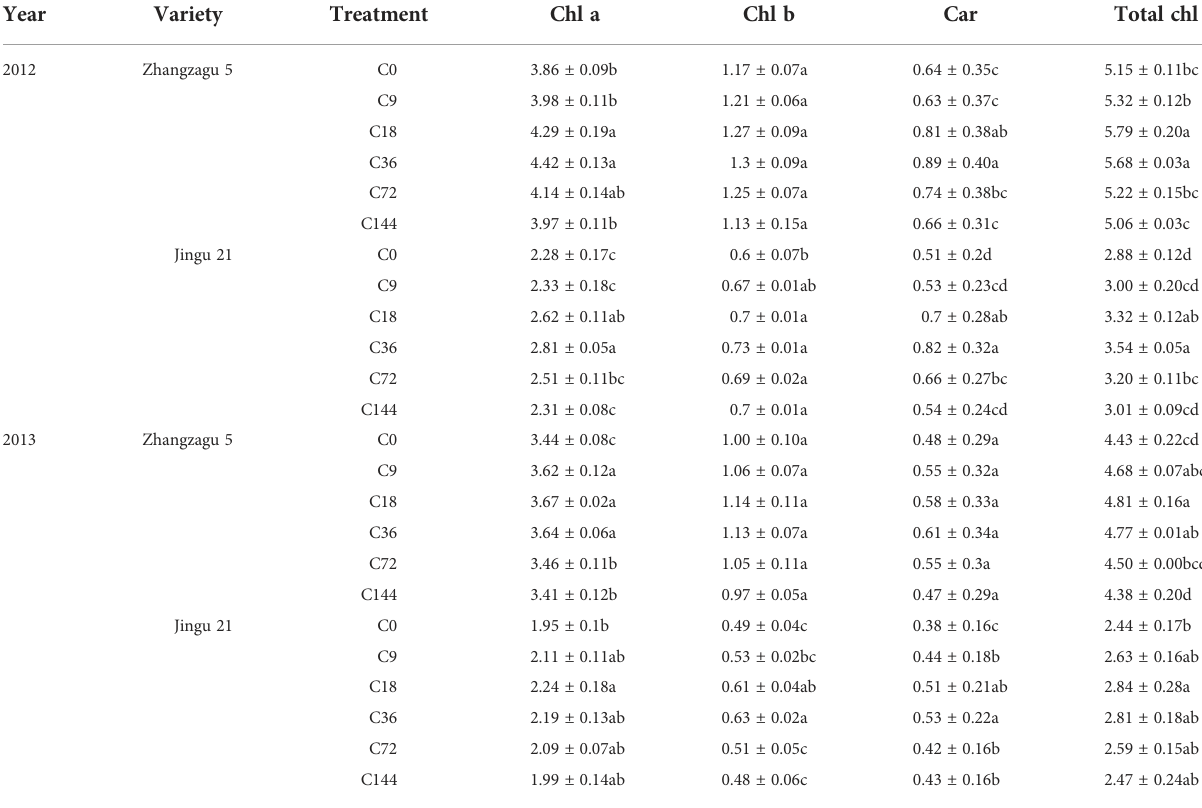
TABLE 1 Effects of naphthalene acetic acid on the photosynthetic pigment contents in leaves of foxtail millet (mg/L FM).